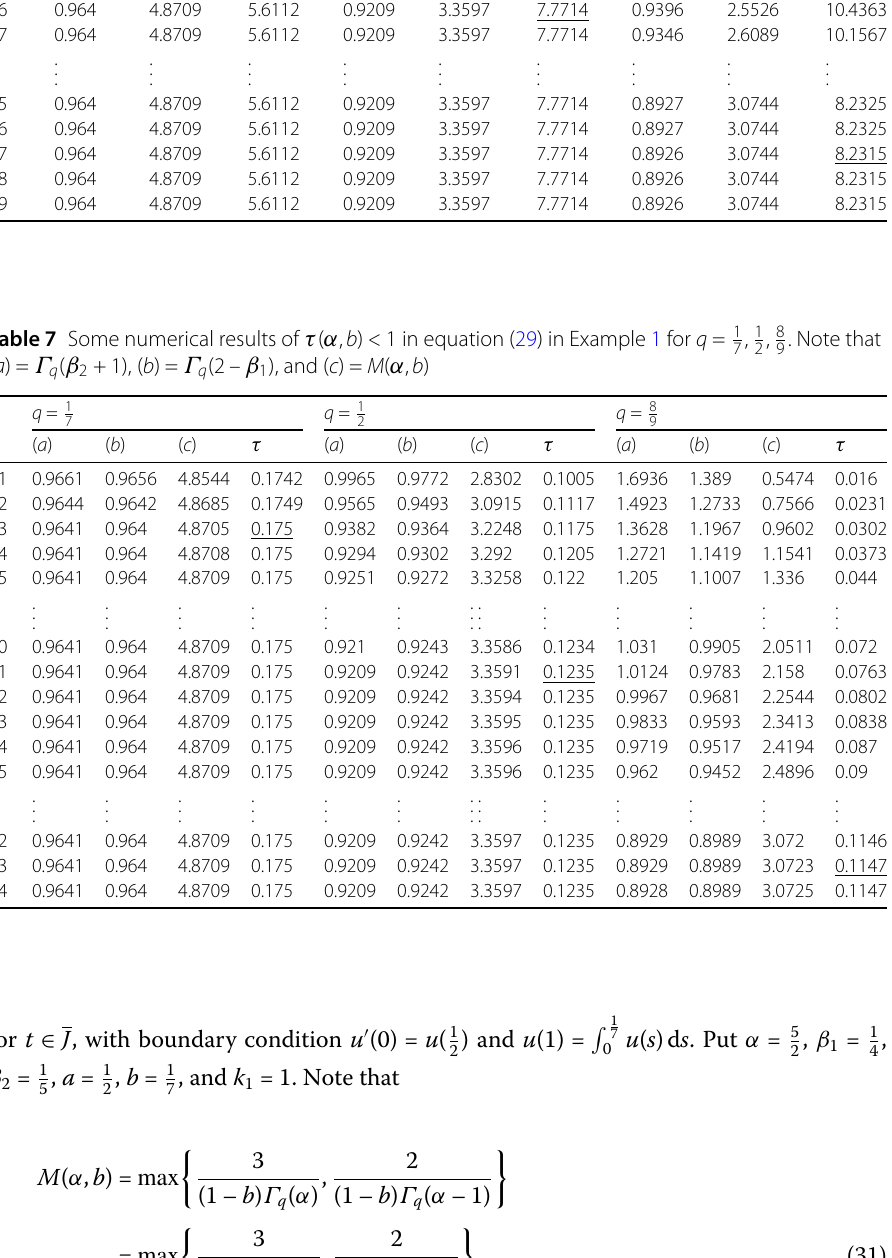
Table 6 Some numerical results of Λ > 1 in equation (28) in Example 1 for q = 1